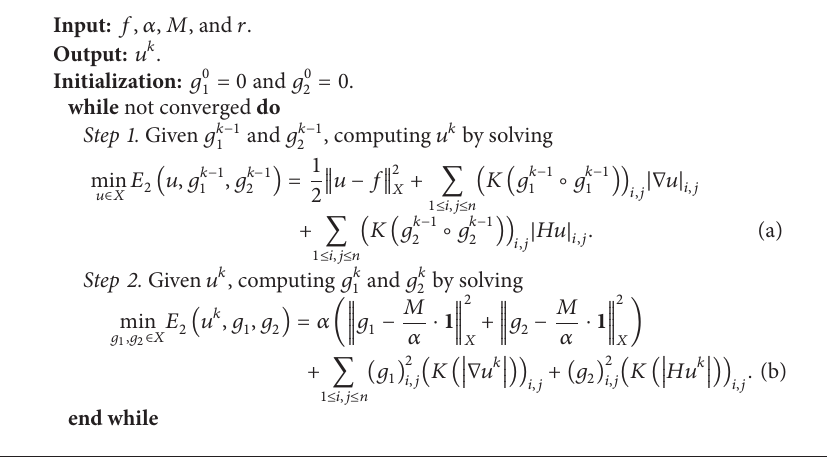
Algorithm 2: The alternating minimization method for solving Model